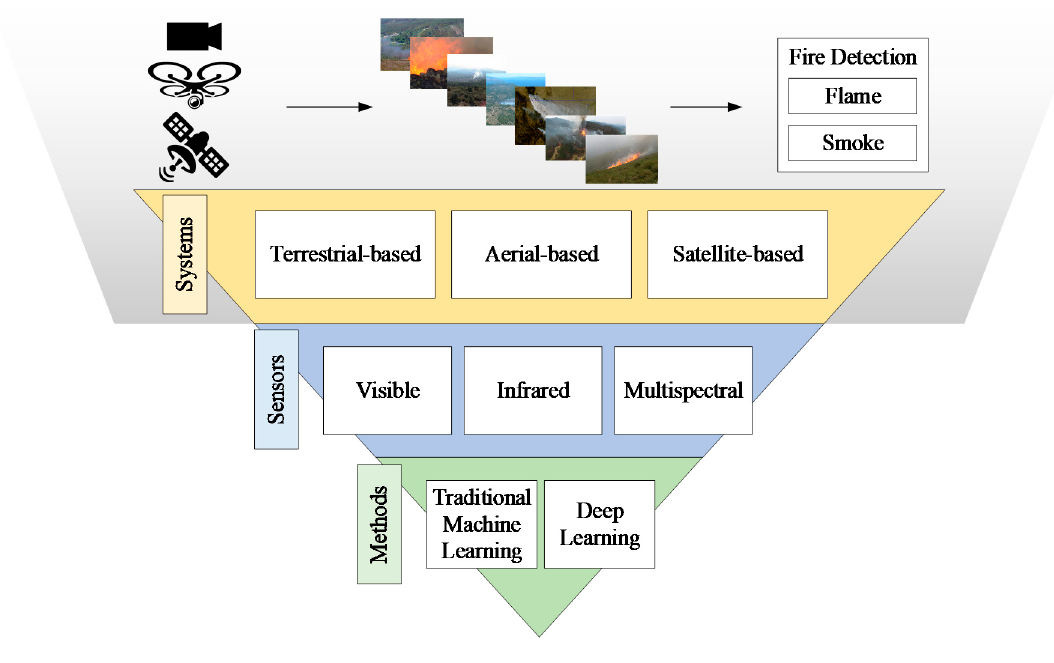
Figure 1. Generalized multispectral imaging systems for early fire detection.